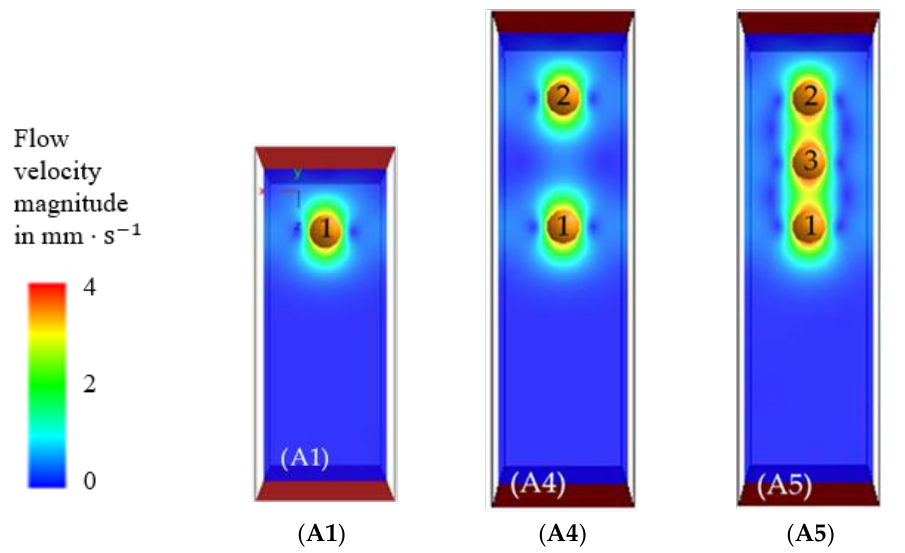
Figure 16. Variation of number and distance between particles settling in a row. Particle 1 has the same initial position in all simulations. Particle 2 has the same position in A4 and A5. ( A1 ) basic model, ( A4 ) basic model enlarged in height with one additional particle, ( A5 ) basic model enlarged in height with two additional particles, ( t = 2 ms).